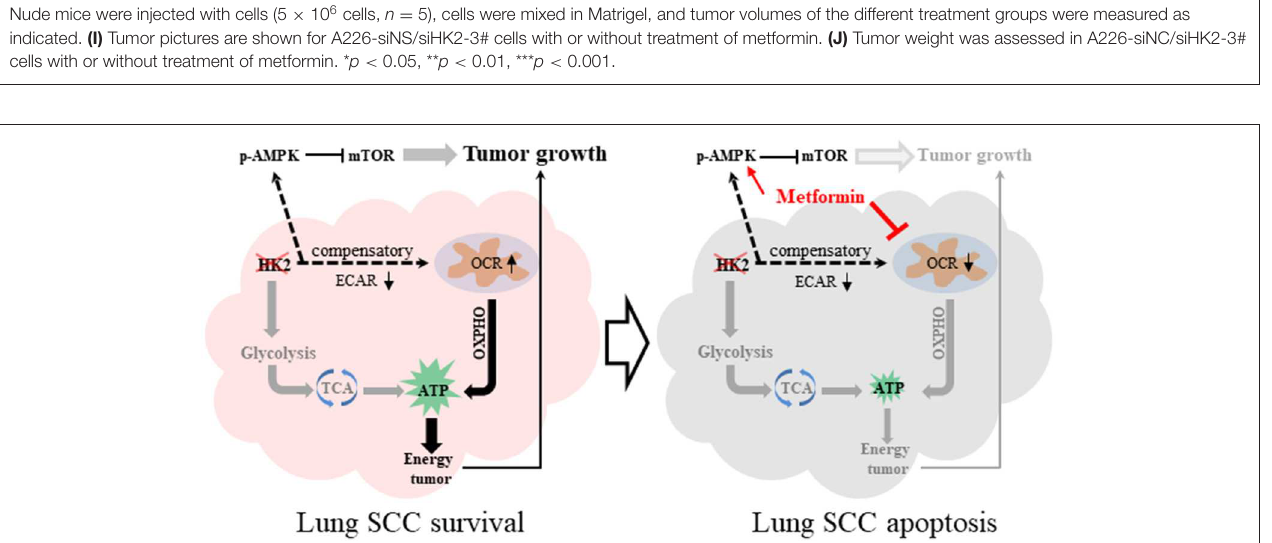
FIGURE 7 | Graphical summary. HK2 depletion leads to oxidative phosphorylation compensatory increase. The combination therapy of HK2 depletion and metformin treatment leads to more lung SCC